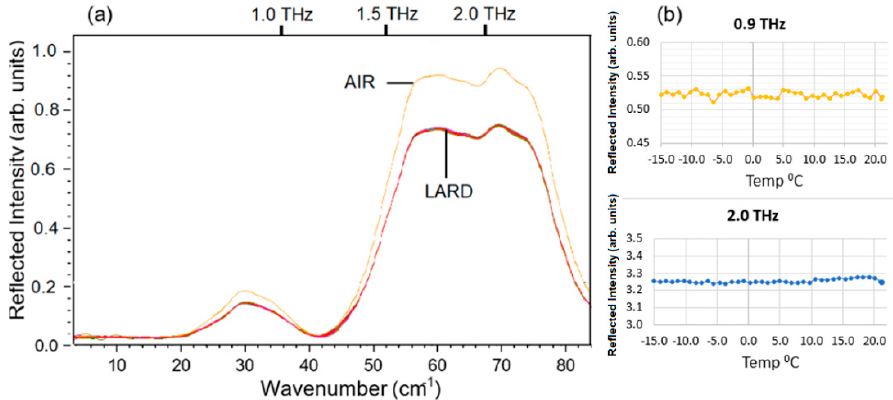
Figure 5. Raw data reflected signal intensity of lard (in arbitrary units). ( a ) The entire spectral range − 15 °C to 24 °C, showing a tight grouping. ( b ) Spectral band centered on 0.9 THz at − 15 °C to 24 °C. ( c ) Spectral band centered on 2.0 THz. The reflected signal intensity does not show any temperature variation.